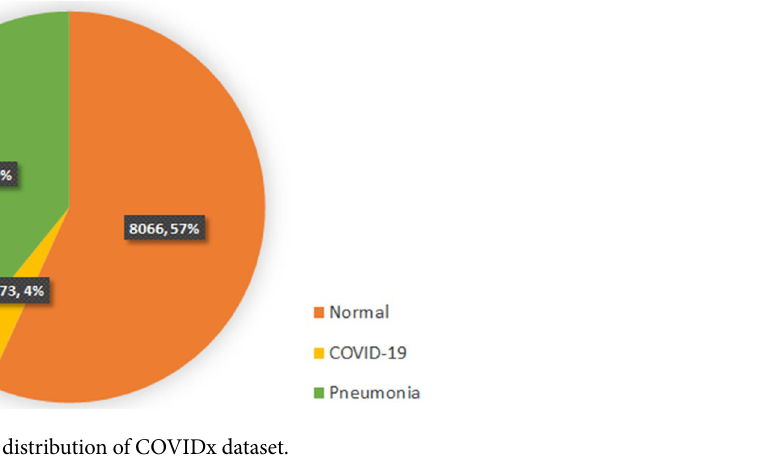
Figure 1. Class distribution of COVIDx